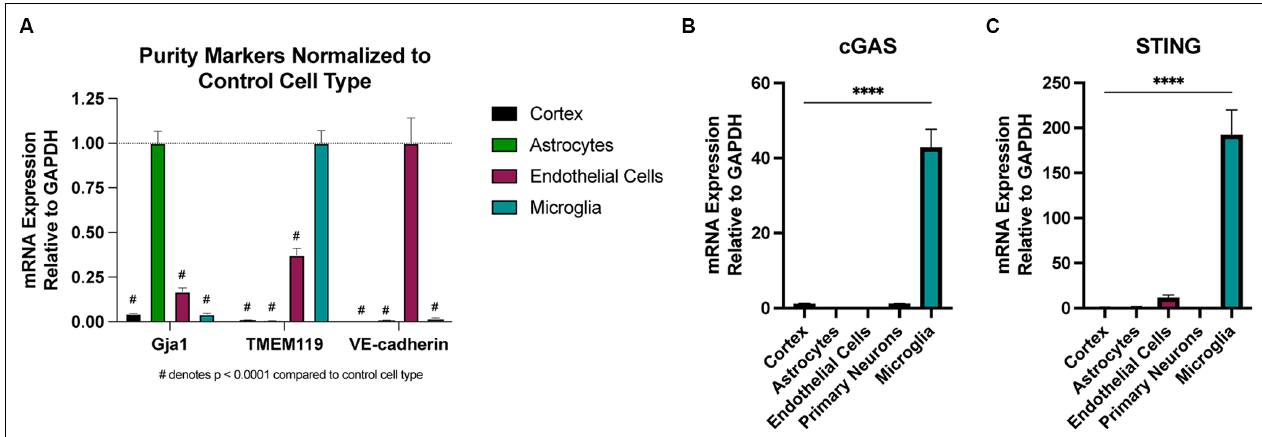
FIGURE 5 | Microglia are the predominant cell type expressing cGAS and STING in the CNS. Cell type specific populations were isolated from naïve (uninjured) WT male animals. (A) mRNA expression of gap junction associated protein 1 ( Gja1 ), transmembrane protein 119 ( TMEM119 ), and vascular-endothelial cadherin ( VE-cadherin ), genes characteristic of astrocytes, microglia, and endothelial cells, respectively. Data is normalized to the characteristic (control) cell type to show the purity of isolated populations. # p < 0.0001 compared to control cell type. (B) cGAS and (C) STING mRNA expression in isolated cell types and whole cortex. n = 3–5 per cell type. ∗∗∗∗ p <